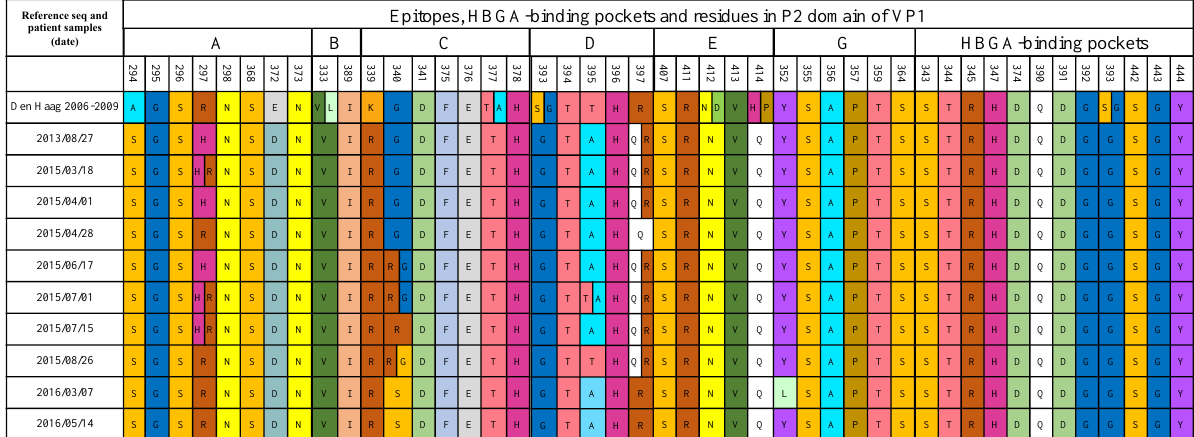
Figure 3. Amino acid changes within the proposed immunodominant epitopes of P2 domain of VP1 (A – E and G) [7] and HBGA binding pockets [15 – 17] among the patient sample sequences (date) and Den Haag 2006 – 2009 reference sequence for comparison.